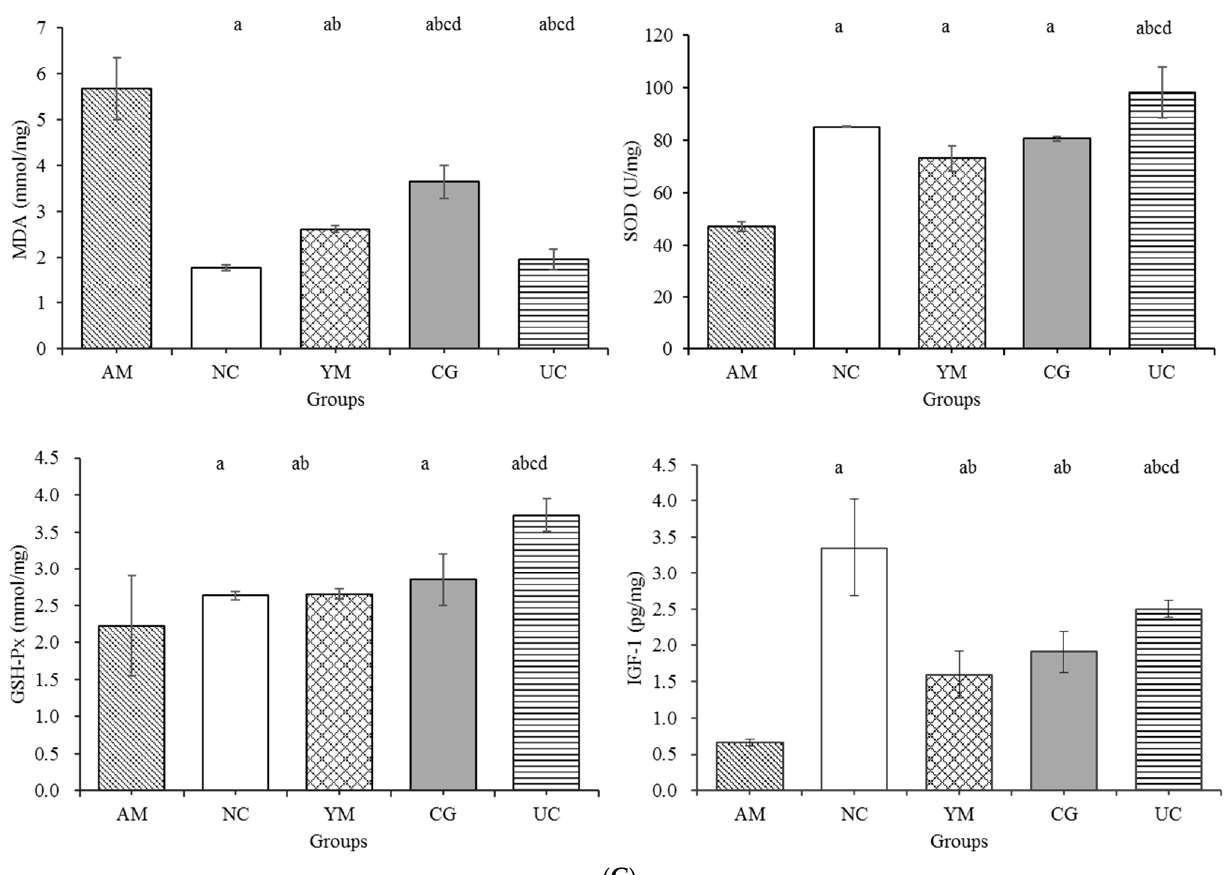
Figure 5. H&E staining of the gastrocnemius muscle and its characteristic parameter. ( A ) H&E staining of the gastrocnemius. The bar indicates 50 μ m. Magnification: 40×. ( B ) Diameter, number, and cross-sectional area of muscle fibers. ( C ) Biomarkers including oxidative stress and monokines IGF-1. The data are expressed as the means ± SD, n = 5; a p < 0.05 versus the AM group, b p < 0.05 versus the NC group, c p < 0.05 versus the YM group, d p < 0.05 versus the CG group.